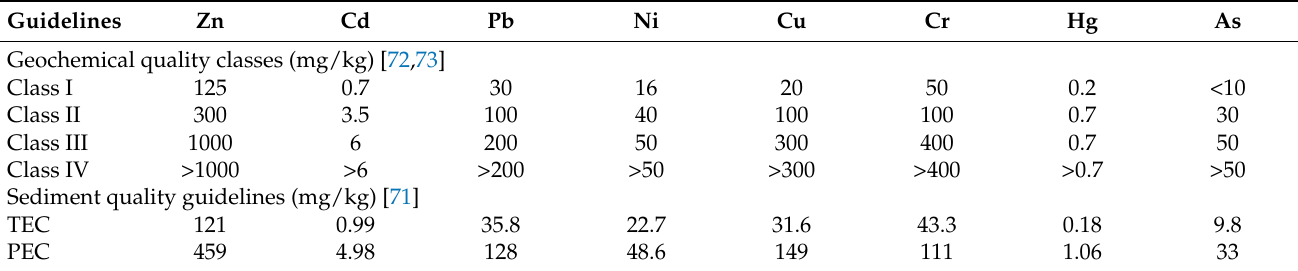
Table 2. Classification of sediment